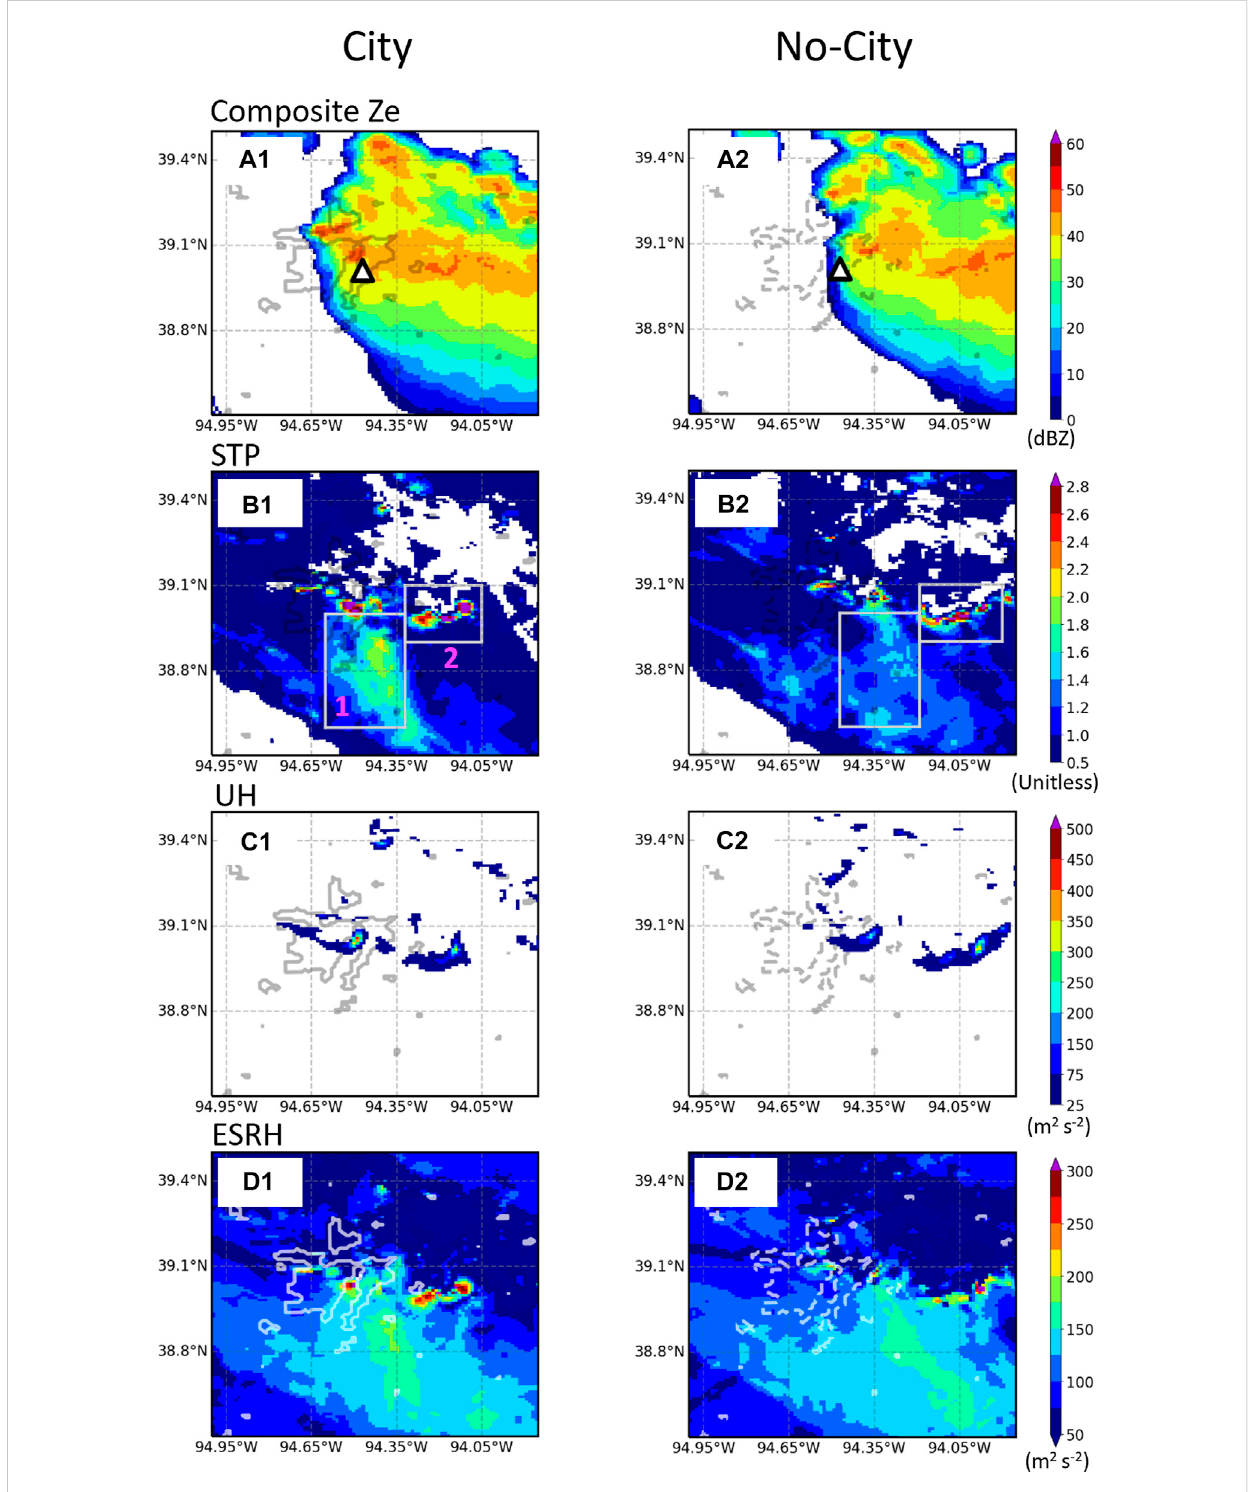
FIGURE 3 Comparisons in (A1,A2) composite radar re fl ectivity, (B1,B2) signi fi cant tornado parameter (STP), (C1,C2) 100m-3 km updraft helicity, and (D1,D2) effective storm-relative helicity (ESRH) between the City (left column) and No City (right column) simulations at 23:30 UTC. The white triangle in (A1,A2) indicates the location of the fi rst tornado report at 23:33 UTC. The white boxes in (B1,B2) denote regions 1 and